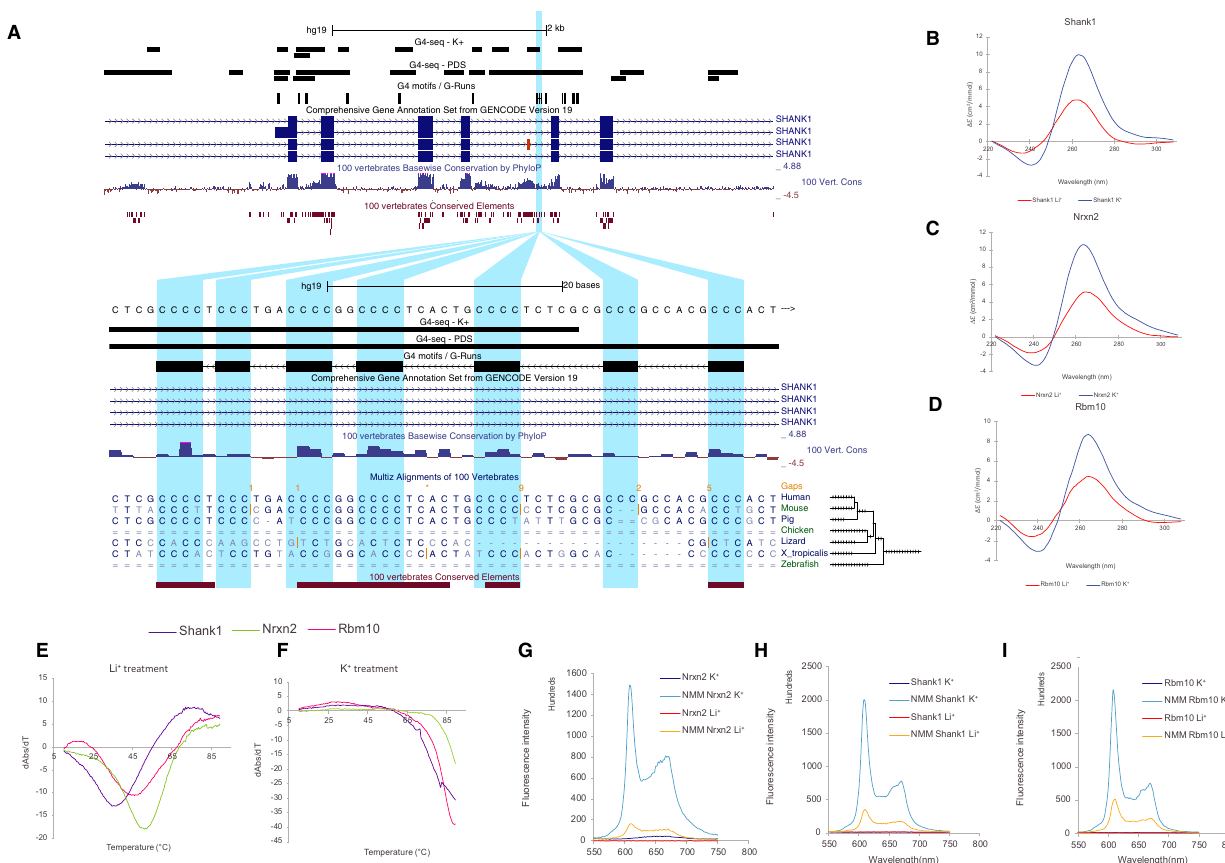
Fig. 4 Targeted validation of RNA G4s found in splicing sites in presence of a G4 stabilising cation (K + ) and a non-G4 stabilising cation (Li + ). A UCSC screenshot displaying the SLC6A17 locus and the distribution of G4 consensus motifs, G4-seq derived G4 peaks and protein domains. B – D Circular dichroism (CD) spectra of the three candidate targets for RNA G4 formation potential in presence of two cations. The monovalent ion-dependent nature (G4 stabilised in K + but not in Li + ) and the CD pro fi le (positive peak at 262 nm and negative peak at 240 nm) indicate the formation of RNA G4s with parallel topology. E , F UV-melting pro fi les of the three G4 candidates in presence of Li + and K + . Hyperchromic shift at 295 nm is a hallmark for G4 formation, which can be transformed to a negative peak in the derivative plot (dAbs/dT) for G4 stability analysis. The melting temperature (Tm) of a G4 can be identi fi ed at the maximum negative value. For the K + treatment, the Tms of the RNA G4 are >85 °C. G – I Fluorescence emission associated with NMM ligand binding to RNA G4 candidates in the presence of Li + or K + ions . In the absence of NMM ligand, no fl uorescence was observed at ~610 nm. Upon NMM addition, weak fl uorescence was observed under Li + , which was substantially enhanced when substituted with K + , supporting the formation of RNA G4 which allows recognition of NMM and enhances its fl